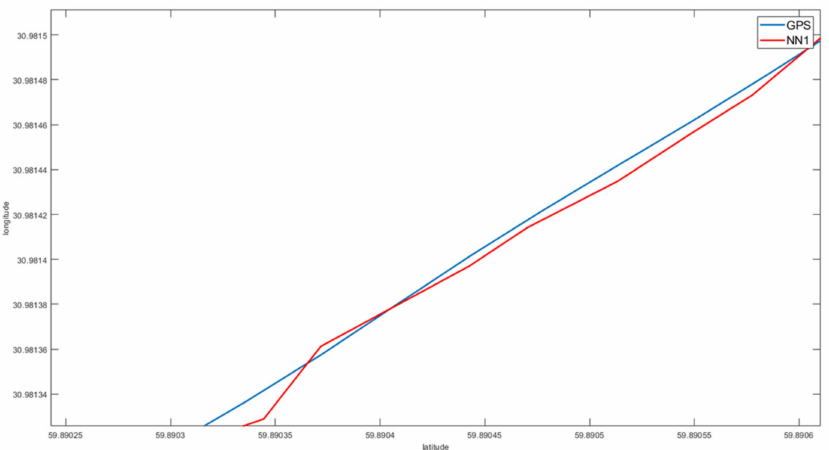
Figure 6. Comparison of the trajectory predicted by the neural network with the reference trajectory on the straight section of the